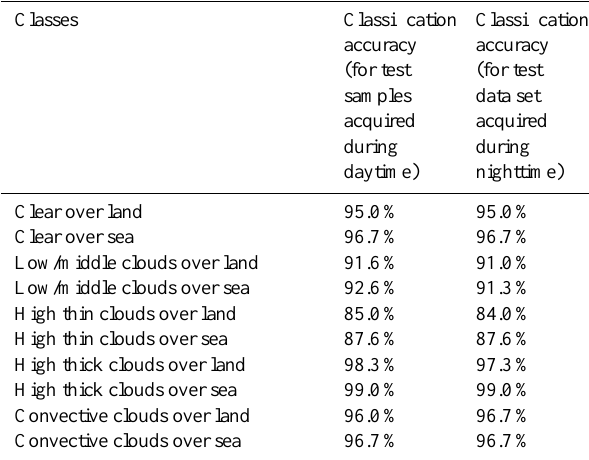
Table 7. Accuracy of the C_MACSP algorithm on an independent data